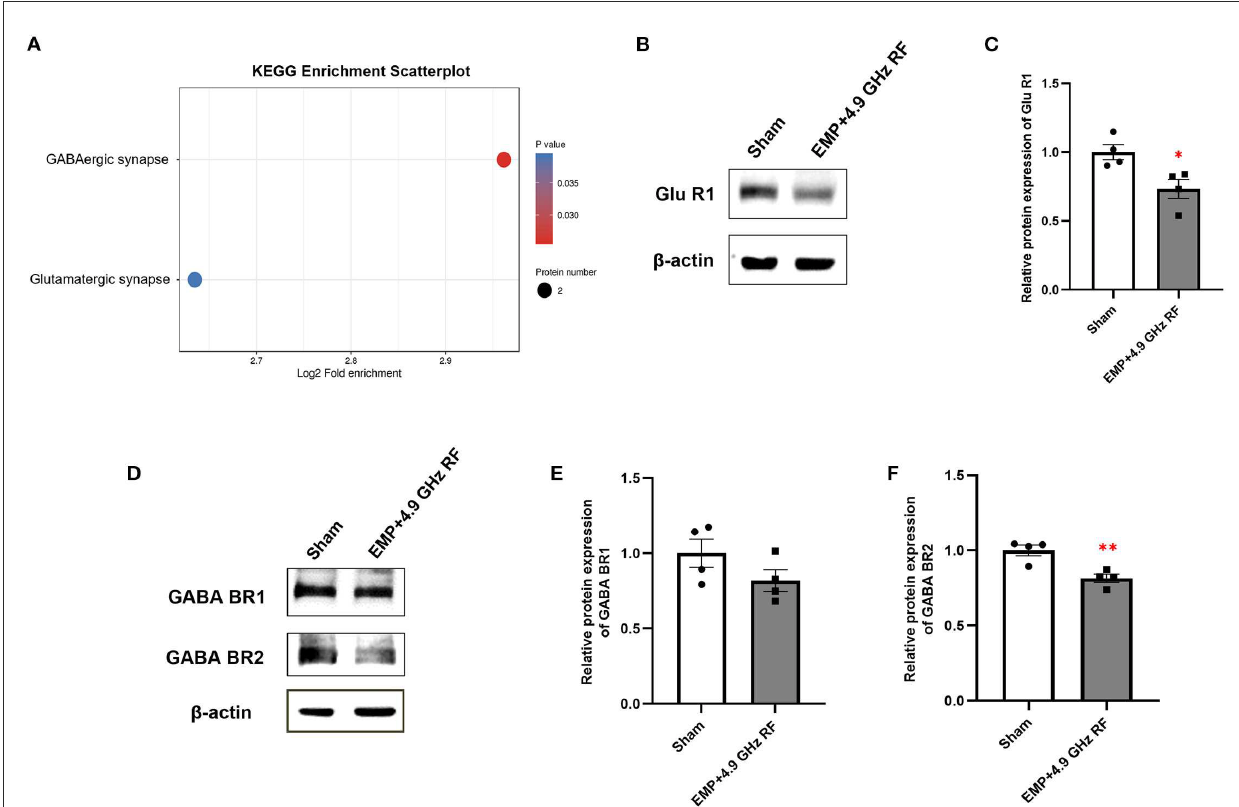
FIGURE4 KEGG analysis of DEGs in the hippocampus of mice. (A) KEGG enrichment analysis of DEPs. (B) Western blot analysis of Glu R1. (C) Relative protein expression level of Glu R1. Western blot analysis of GABA BR1 and GABA BR2 (D) and relative protein expression levels (E, F) . n = 4 for each group, * P < 0.05, ** P < 0.01 vs. Sham group.